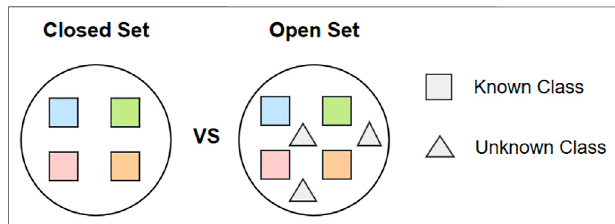
FIGURE2| Closedspacevs.Openspace.Inclosedspacedetection,all categories are known (squares in the picture), while in an open space detection notonly knowncategoriesbut also unknowncategories (triangles in the picture) are included.